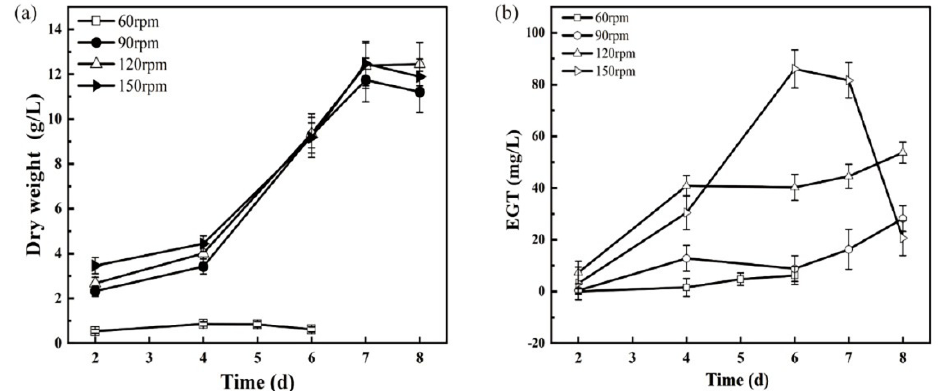
Figure 3. Effects of different mixing speed on dry weight and ergothioneine production of Panus conchatus . ( a ) dry weight ( b ) ergothioneine production.